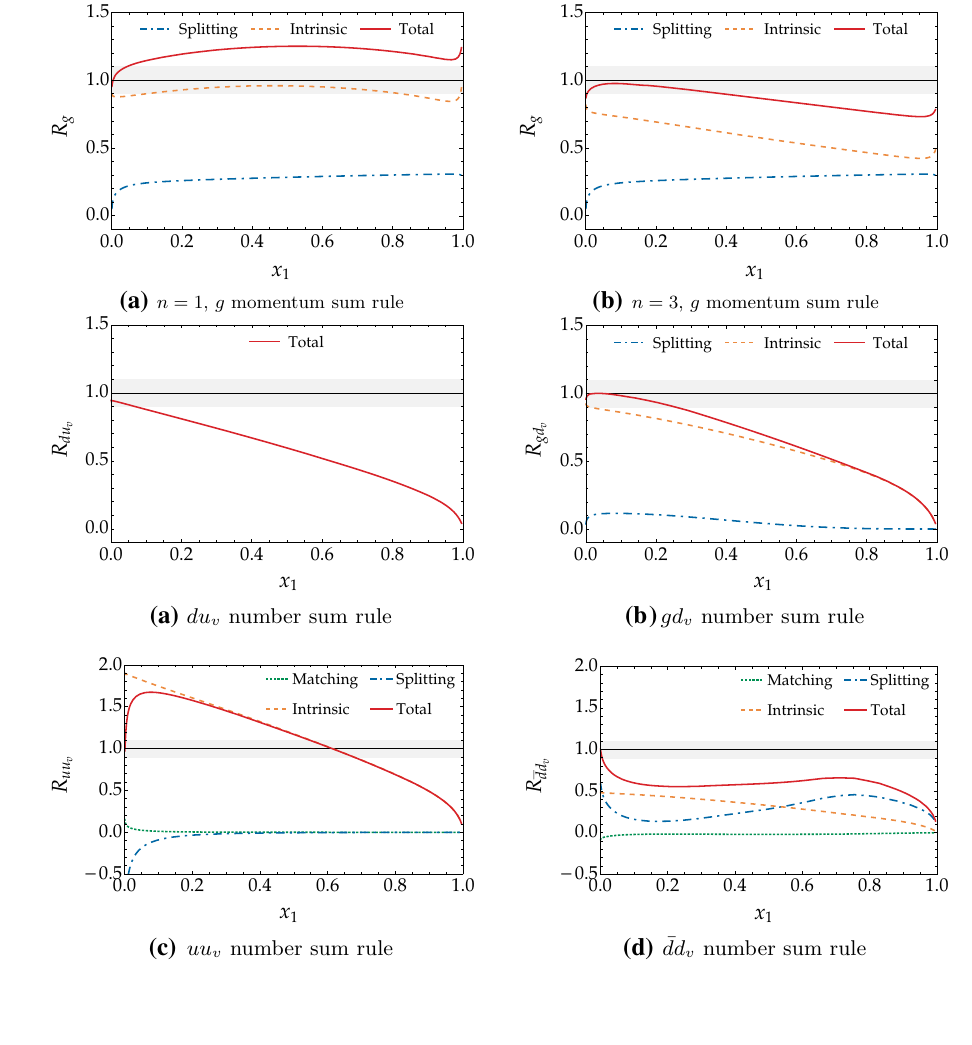
grey band. Not shown is the separate contribution from the matching term F match , which is negligible in this case. The remaining plots in this section will follow the same conventions unless explicitly stated otherwise